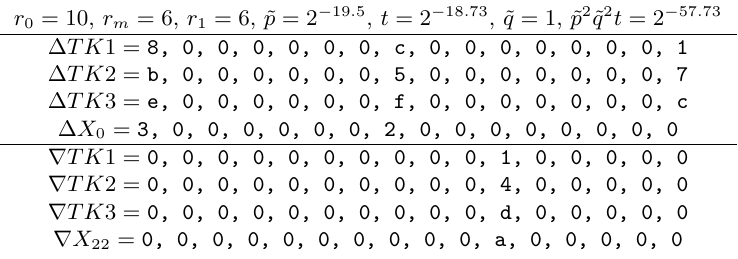
Table 5: The 22-round related-tweakey boomerang distinguisher for SKINNY-64-192 . r 0 = 10, r m = 6, r 1 = 6, ˜ p = 2 − 19 . 5 , t = 2 − 18 . 73 , ˜ q = 1, ˜ p 2 ˜ q 2 t = 2 − 57 . 73